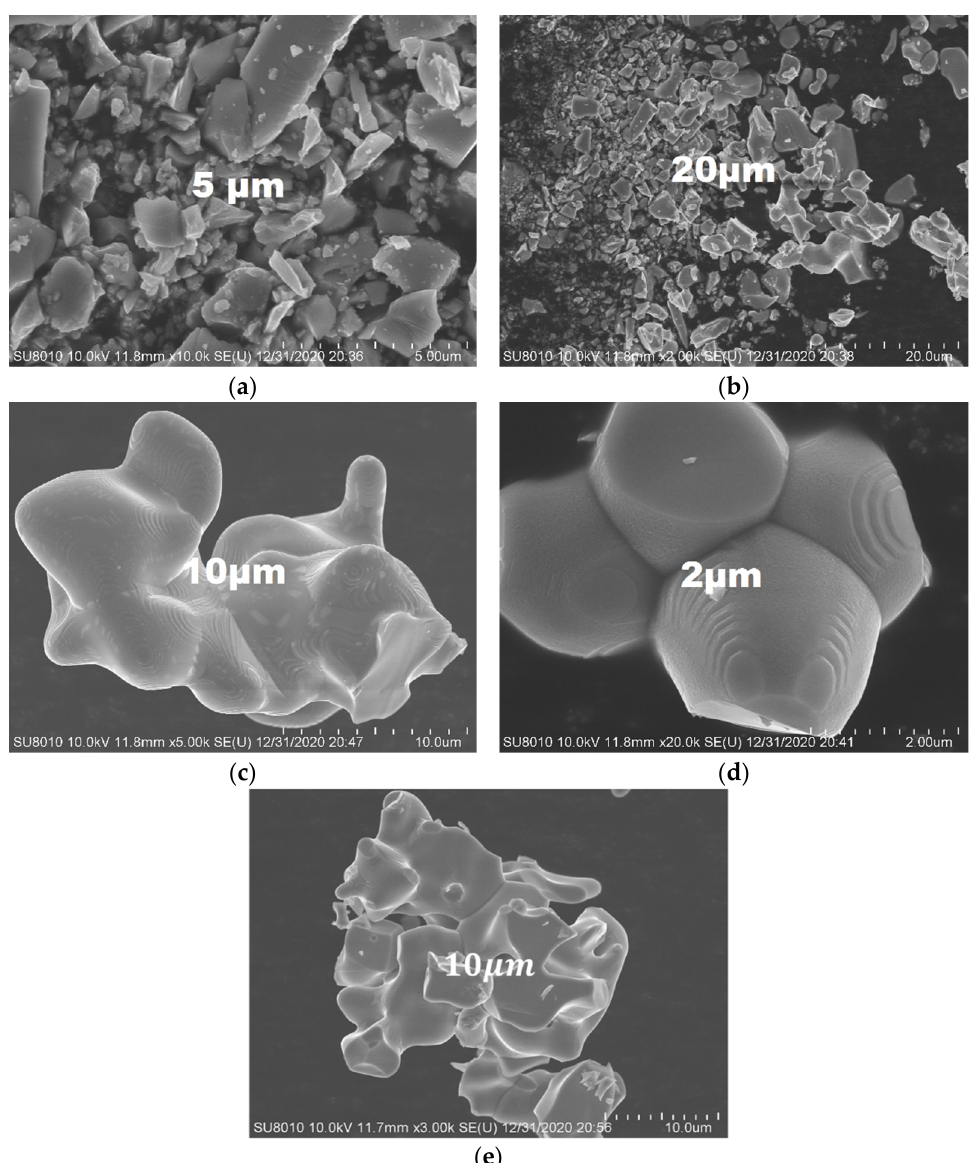
Figure 10. SEM micrographs of the treated (Fe,Co,Mn)Ox material: ( a ) Image acquired using a 10 kv accelerating voltage at 10,000× length of 5 μ m; ( b ) image acquired using a 10 kv accelerating voltage at 2000× length of 20 μ m; ( c ) image acquired using a 10 kv accelerating voltage at 5000× length of 10 μ m; ( d ) image acquired using a 10 kv accelerating voltage at 20,000× length of 2 μ m, and ( e ) image acquired using a 10 kv accelerating voltage at 3000× length of 10 μ m.